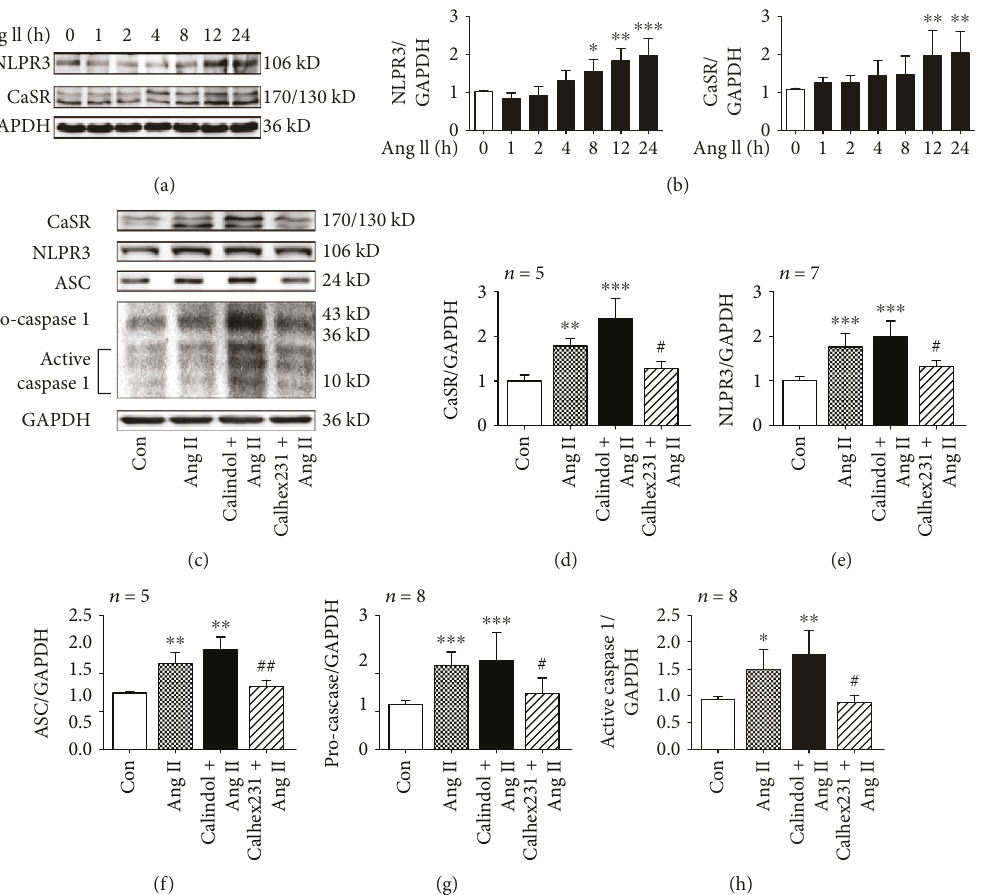
Figure 3: Calhex 231 prevented the activation of NLRP3 in fl ammasome in VSMCs induced by Ang II. (a) Western blot images of CaSR and NLRP3 expression induced by Ang II in a time-dependent manner. (b) Quanti fi cation of the proteins from A. ∗ P < 0 05 , ∗∗ P < 0 01 , and ∗∗∗ P < 0 001 vs. 0h, n = 4 . (c) CaSR regulated NLRP3 in fl ammasome activation induced by Ang II. Western blot images of CaSR, NLRP3, ASC, and caspase 1. (d – h) Quantitative analyses of the proteins from C. ∗ P < 0 05 , ∗∗ P < 0 01 , ∗∗∗ P < 0 001 vs. control; # P < 0 05 and ## P < 0 01 vs. Ang